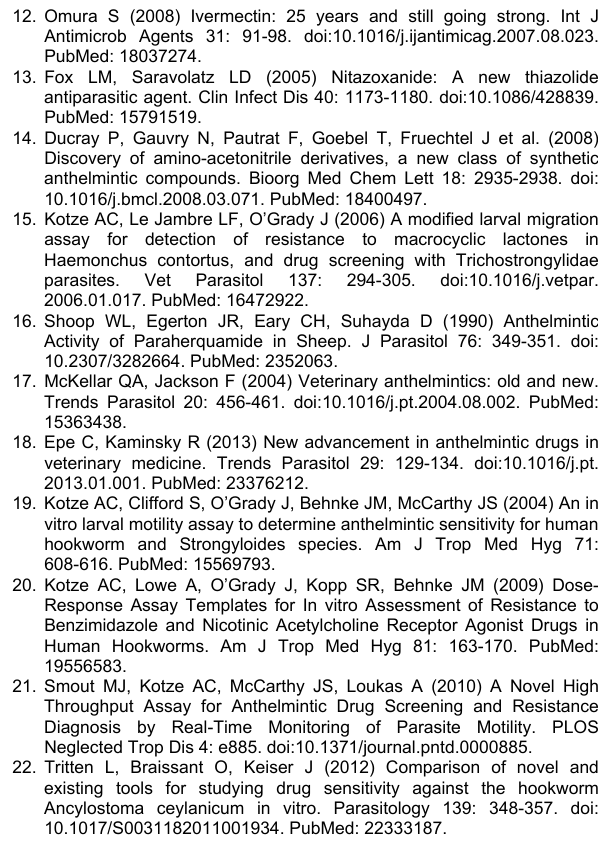
Figure S1. Intoxication of Ancylostoma ceylanicum adults in vitro using five doses of either albendazole (ALB), ivermectin (IVM), nitazoxanide (NTZ), or pyrantel (PYR) as scored by motility index. Parasites were scored daily for motility on a scale of 3-0. Data are from the same experiments in Figure 1.